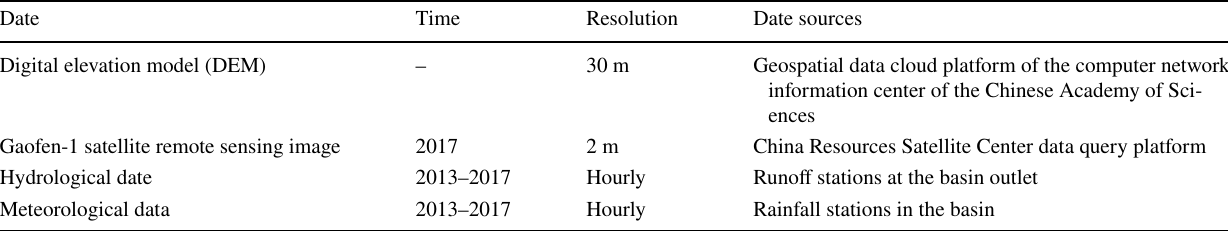
Table 2 Research data and